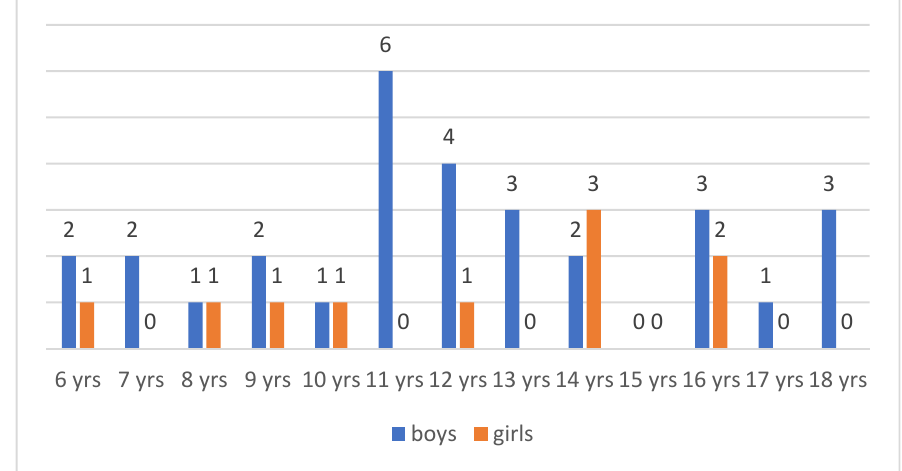
Figure 1. Age of children with TS.